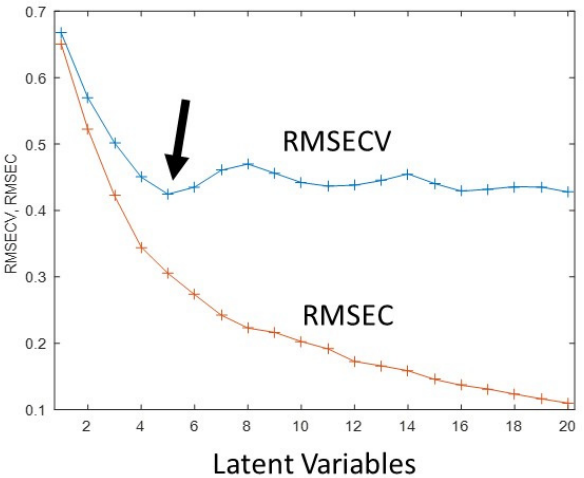
Figure 10. Examples of RMSEC-RMSECV plots for decision-making. The best number of factors (Latent Variables) is indicated with an arrow. Note that the RMSEC (root mean square error in calibration) diminishes monotonically; so it is useless to select the dimensionality of the models. RMSECV stands for root mean square error in cross-validation.